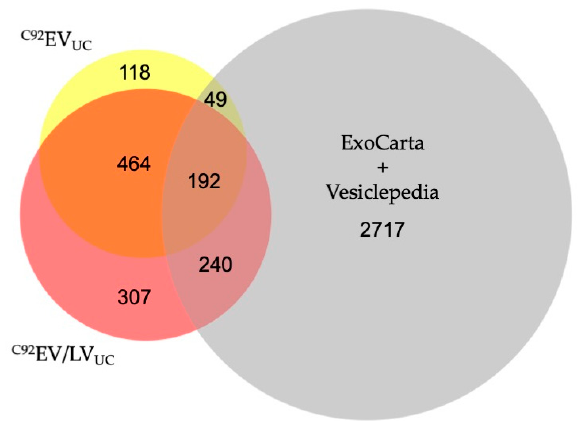
Figure 9. Area-proportional Venn diagram for the total number of identified proteins in C92 EV UC and C92 EV/LV UC within the combined Vesiclepedia and ExoCarta database. Among all the identified proteins in C92 EV UC and C92 EV/LV UC , 167 were uniquely iden- tified in C92 EV UC and 548 were uniquely identified in C92 EV/LV UC (Supplementary Table S1). protein classes (Table 4). Table 4. Summary of protein classes identified in both C92 EV UC and C92 EV/LV UC , or only in either C92 EV UC or C92 EV/LV UC .